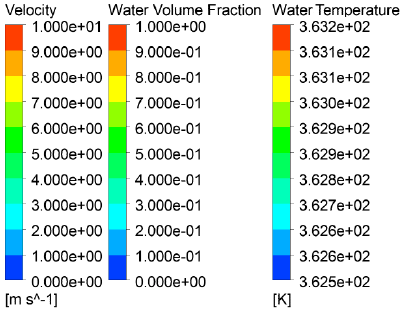
Figure 4. Cavitation at test section mid-plane, σ = 2.221. ( a ) Vector lines; ( b ) distribution of water volume fraction; ( c ) distribution of temperature; ( d ) vortical structures behind the cylinder (Q crite- rion) colored with temperature.